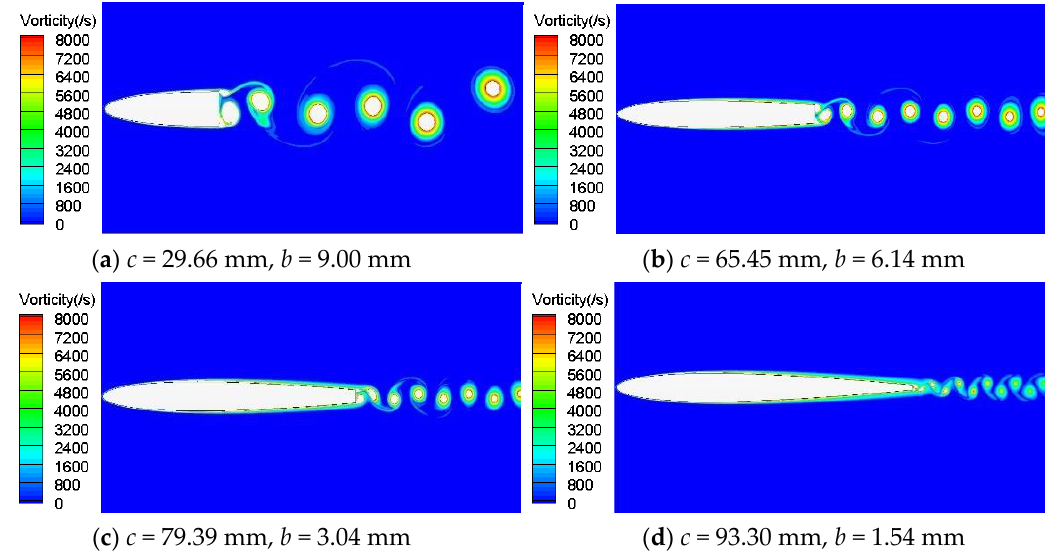
Figure 17. Vortex shedding with different trailing-edge thicknesses.